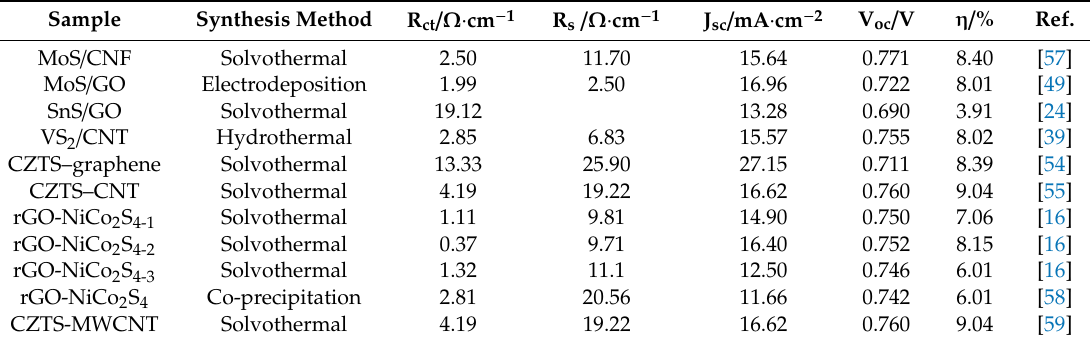
Table 5. Photovoltaic parameters for various metallic sulphide / carbon composite